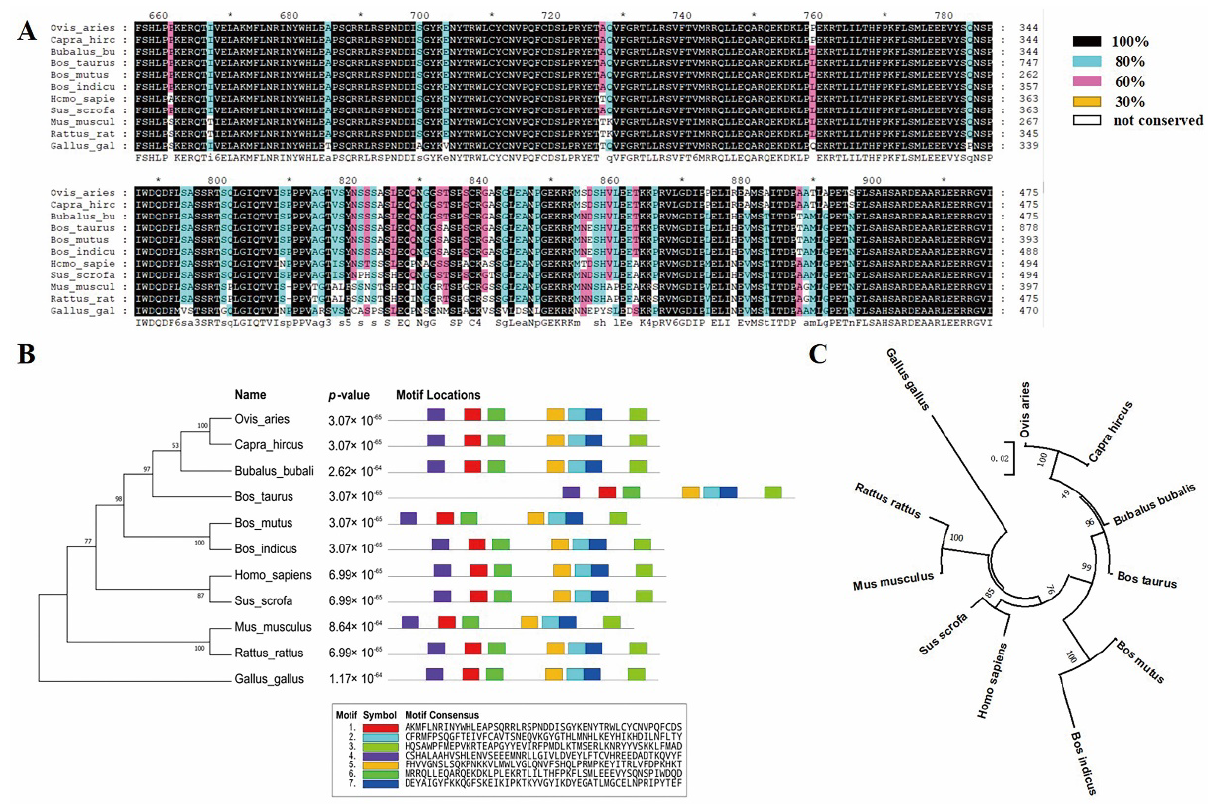
Figure 1. Biological evolution and conservation of KAT2B. ( A ) Multiple sequence alignment of KAT2B for the 11 species. The degree of similarity is delineated using different background shading: black − 100%, blue − 80%, pink − 60%, yellow − 30%, and white − not conserved. ( B ) Phylogenetic tree (Left) and motif structural analysis (Right) for the 11 species. Seven significant motifs were identified. The length of the color block shows the position, strength, and significance of a particular motif site. The motif length is proportional to the negative logarithm of the p -value of the motif site, truncated at the height for a p -value of 1 × 10 − 10 . These were are given by motif analysis performed through the MEME suite system. ( C ) Phylogenetic tree for the 11